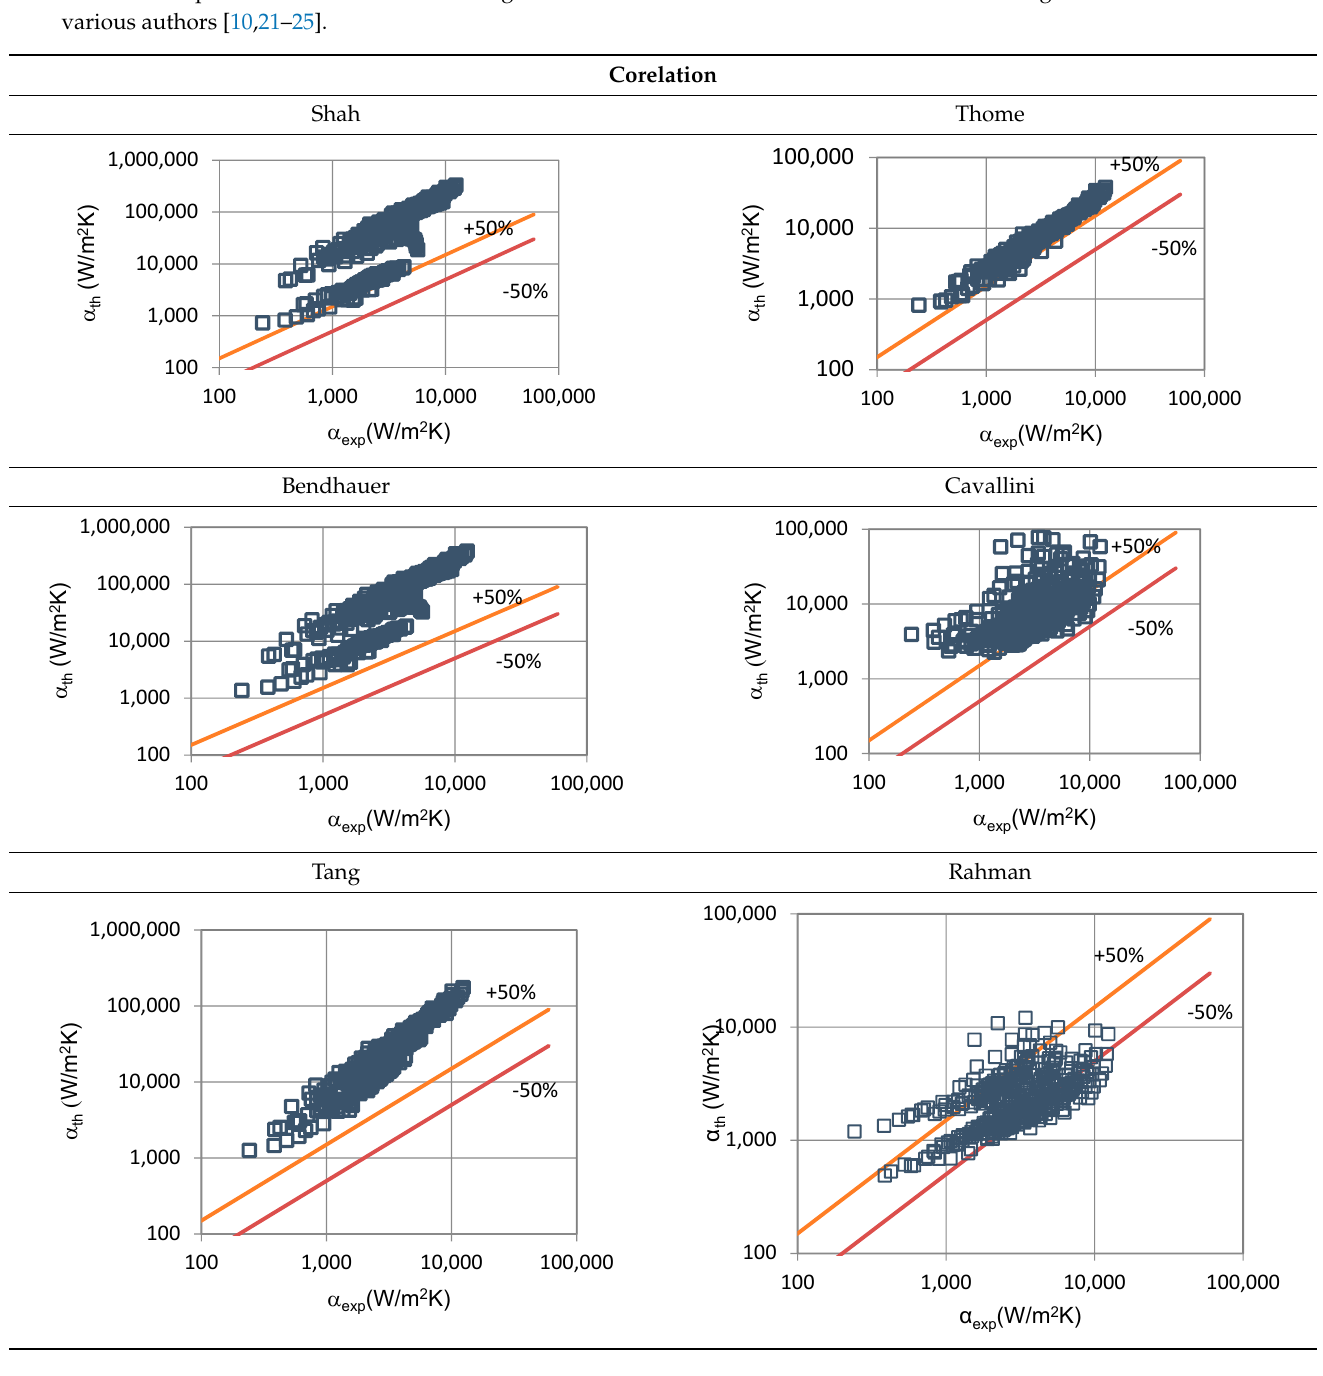
Table 3. Comparison of the pressure drop investigation results with the results of calculations according to the correla ‐ tions of various authors [9,26–29].